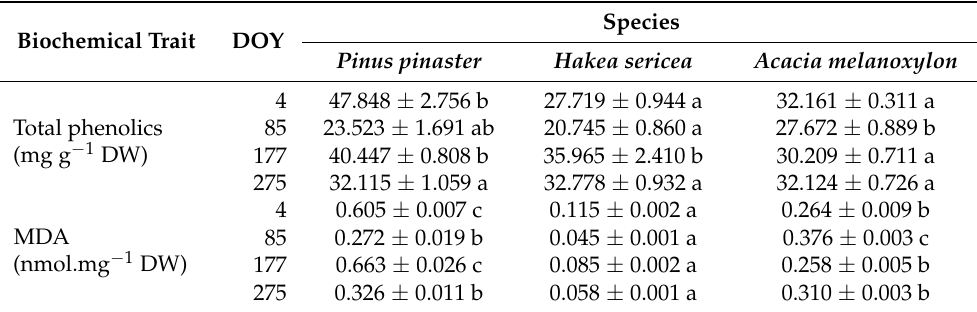
Table 3. Total phenolic and MDA contents in the leaves of all analyzed species ( Pinus pinaster , Hakea sericea and Acacia melanoxylon ) on the four sampling dates (DOY 4, DOY 85, DOY 177 and DOY 275). Within each row, different lowercase letters indicate significant differences ( p < 0.05) between species according to Tukey’s HSD test results. Species Biochemical Trait DOY Pinus